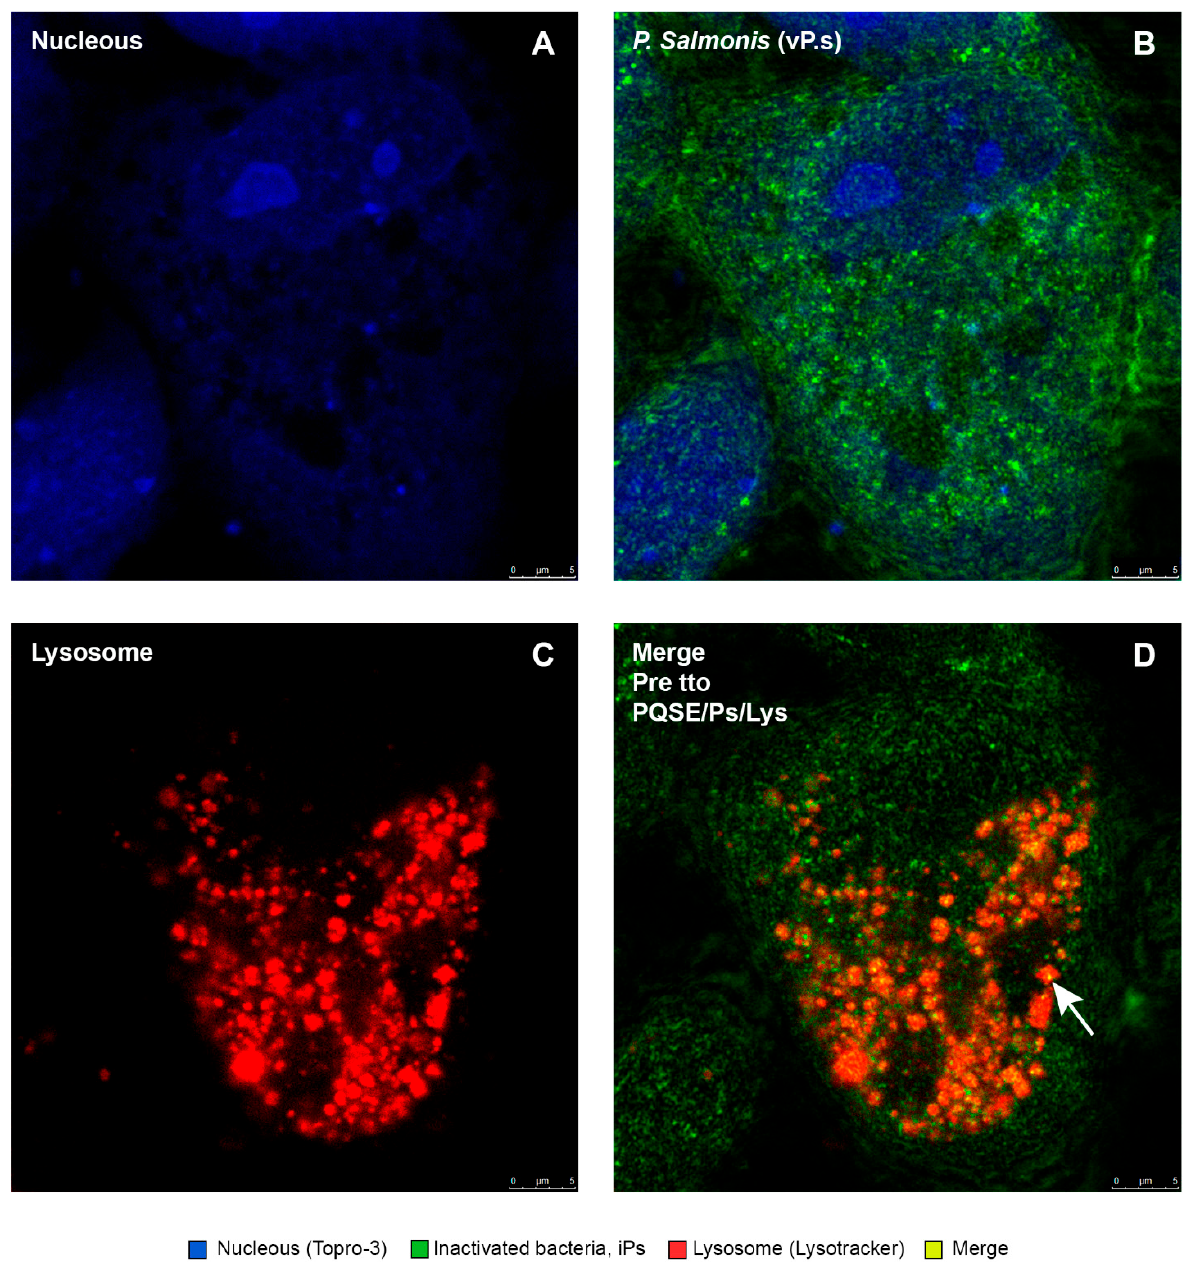
Figure 12. Location of P. salmonis in SHK-1 cells pre-treated with 0.5 µg/mL of PQSE (24 hpi). Photomicrographs show the location of the virulent P. salmonis (vPs) strain LF89 in SHK-1 cells pre-incubated with PQSE for 4 h, prior to challenge with the bacterium. ( A ) Nuclei of cells marked with TOPRO-3 (blue) can be observed. ( B ) Virulent bacteria (vPs) (green) can be observed. ( C ) Lysotracker Red DND-99-labeled lysosomes distributed throughout the cell (red) can be observed, and ( D ) vPs bacteria co-located within lysosomes were observed to be yellow-orange as an indicator that there was maturation of the phagosome that contained the bacterium and phagosome–lysosome fusion.